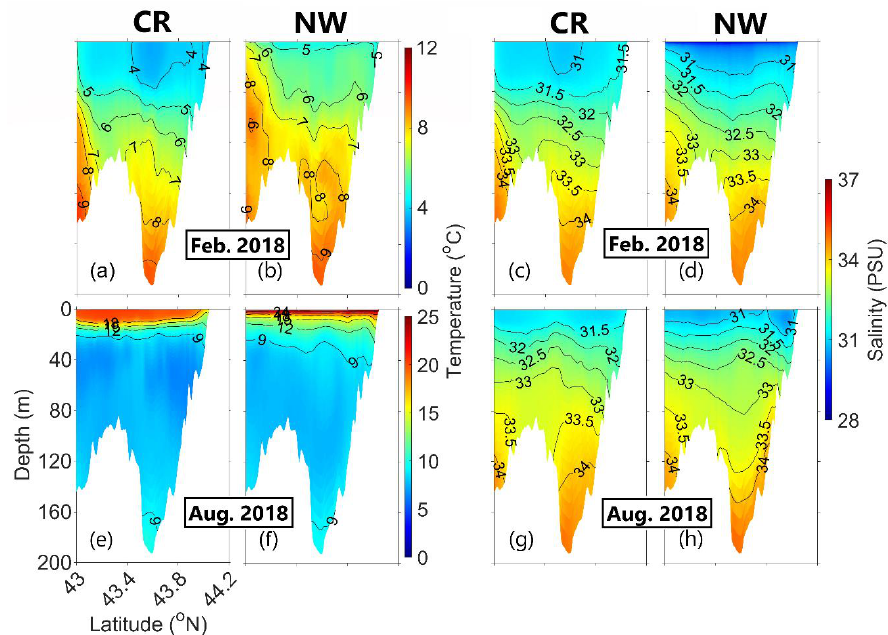
Figure 13. Vertical profiles of monthly-mean ( a , b , e , f ) temperature and ( c , d , g , h ) salinity in ( a – d ) February and ( e – h ) August 2018 produced by submodel L3 along transect PP’ (shown in Figure 1c) in cases ( a , c , e , g ) CR and ( b , d , f , h ) NW. In August 2018, 𝑇̅ PP𝐶𝑅 and 𝑆̅ PP𝐶𝑅 in case CR (Figure 13e,g) show a three-layer vertical structure, consisting of a warm (>18 °C) and fresh (<31.5) surface layer in the top ~10 m, a relatively cool (~6 °C) and fresh (between 32 and 33) intermediate layer between 20 m and 80 m, and a warmer (between 8 °C and 9 °C) and saltier (>33) bottom layer below 80 m. This three-layer structure of hydrography is normally well-established between the late spring and early autumn [1]. The August- mean thermocline along transect PP’ in case CR is nearly horizontal and at depths of about 10 m over the middle shelf of the transect (beyond ~50 km away from the coast), tilts up over the inner shelf, and reaches the surface near the coast (Figure 13e). The tilts of the August-mean thermocline and 31.5-salinity layer over the inner shelf in case CR (Figure 13e,g) are associated by coastal upwelling induced by upwelling-favorable (northeastward) winds in the summer months. The August- mean thermohaline on transect PP’ in case NW is unrealistically too shallow over the middle of the transect (Figure 13f), due to the absence of wind-induced vertical mixing. Furthermore, the August-mean thermohaline in case NW does not tilt up over the inner shelf due to the absence of wind-induced upwelling. Below 30 m, 𝑇̅ PP𝑁𝑊 and 𝑆̅ PP𝑁𝑊 (Figure 13f,h) also have vertical distributions considerably different from the counterparts in case CR (Figure 13e,g) in August 2018. These differences (below 30 m, in August 2018) are partially associated with wind-induced modulation of baroclinic hydrodynamics. The shelf waves excited by winds in submodel L2 are present in case CR, but absent in case NW, also contributing to the differences between 𝑇̅ PP𝐶𝑅 and 𝑇̅ PP𝑁𝑊 and between 𝑆̅ PP𝐶𝑅 and 𝑆̅ PP𝑁𝑊 in August 2018. To quantify the effects of winds on the monthly-mean currents over the swScS, we calculate the impact index ( 𝑊 𝑖𝐷 ) of wind forcing at depth 𝐷 ( 𝐷 equals 0 and 40 at the sea